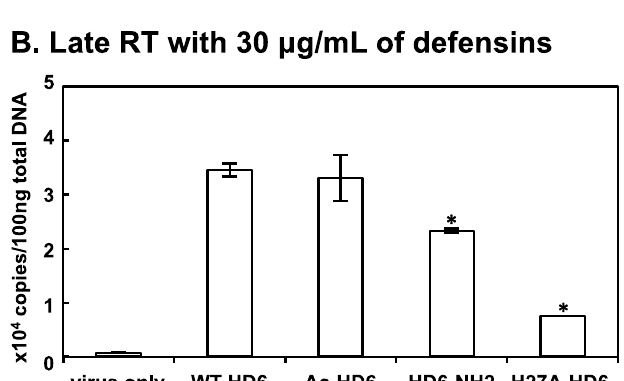
Figure 6. Effects of selected HD6 mutants on HIV reverse transcription. WT HD6 or HD6 mutants were pre-incubated with serum-free HIV-1 JR-FL for 1 h followed by infection of HeLa-CD4-CCR5 cells at 37 °C for 2 h. After washing off unbound viruses, cells were cultured for 12 h before preparation of total DNA. The levels of HIV-1 late RT products were determined by quantitative real-time PCR. The baseline of RT copy numbers from cells infected by HIV without defensins was 679–700. * p < 0.05, WT HD6 versus HD6 mutants at the same concentration; Student’s t -test.